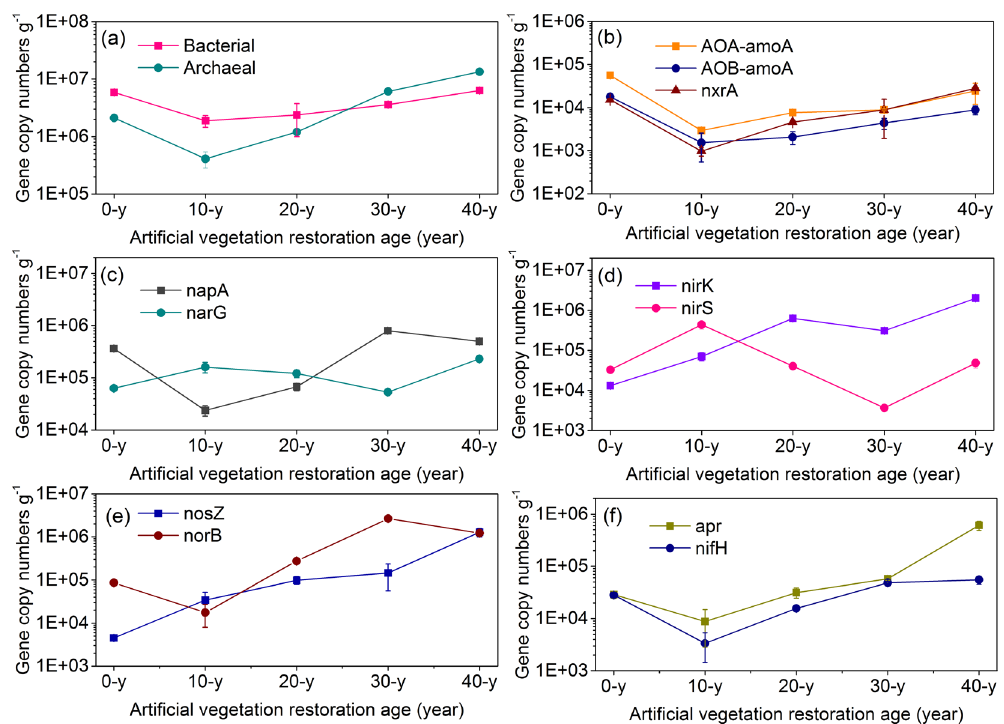
Figure 2. The absolute abundances of bacteria, archaea, and nitrogen functional genes during artificial vegetation restoration. ( a ) Bacterial and archaeal 16S rRNA; ( b ) AOA- amoA , AOB- amoA , and nxrA ; ( c ) narG and napA ; ( d ) nirK and nirS ; ( e ) nosZ and norB ; and ( f ) apr and nifH . The absolute abundances (copies g − 1 ) are shown on log10 scale (Y-axis). Standard deviations of three replicates are indicated by error bars. Invisible error bars indicate that the standard deviations are smaller than the marker